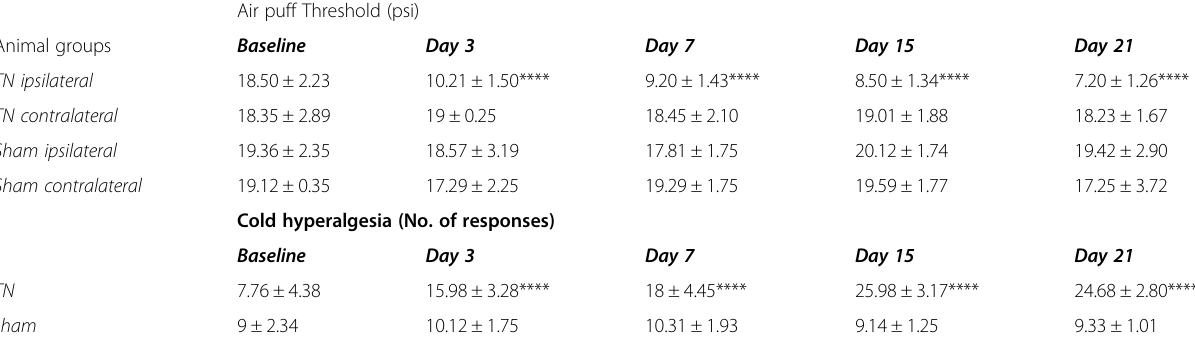
Table 1 Mechanical and thermal orofacial pain sensitivity tested by air puff test and acetone drop on trigeminal neuralgia and sham rat models Air puff Threshold (psi) Animal